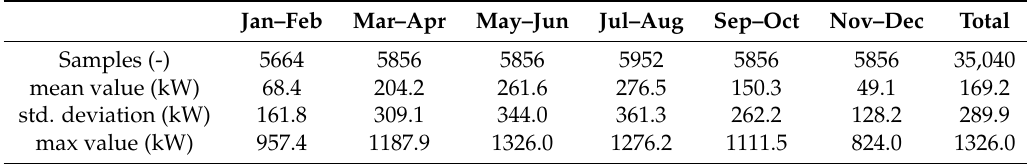
Table 1. PV power output of the plant with 15-min resolution for